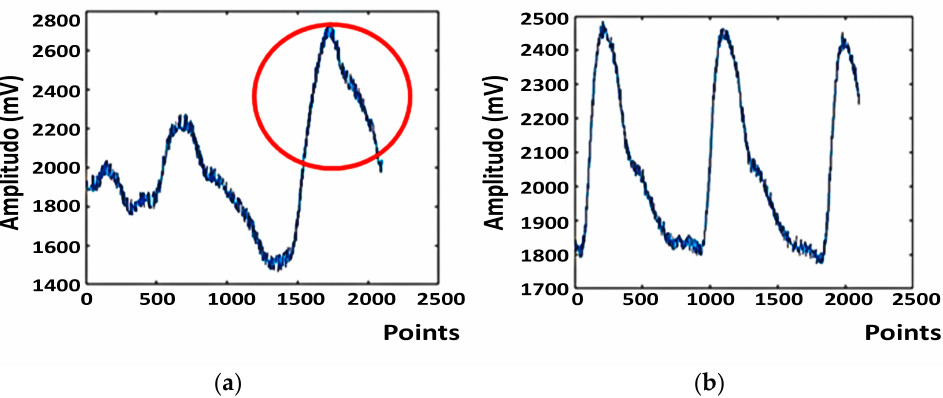
Figure 6. ( a ) Characteristics of unacceptable PPG signal. ( b ) Characteristics of acceptable PPG